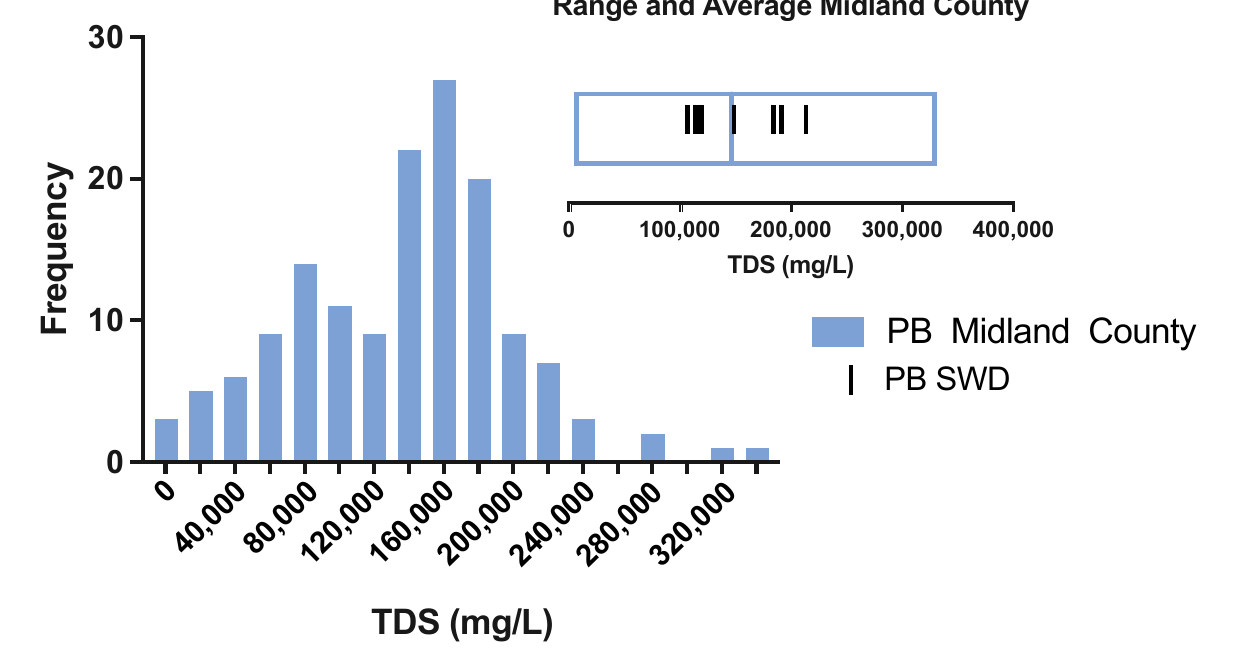
Figure 9. Histogram of TDS concentrations from PB data reported by the USGS for wells located in Midland County [50]. The data illustrate the concentrations stated for conventional wells. The graph inset in the top right corner represents the conventional waste range and the average of 149 Midland County PW data points. The black lines denote individual TDS values from the PB SWD sample set.